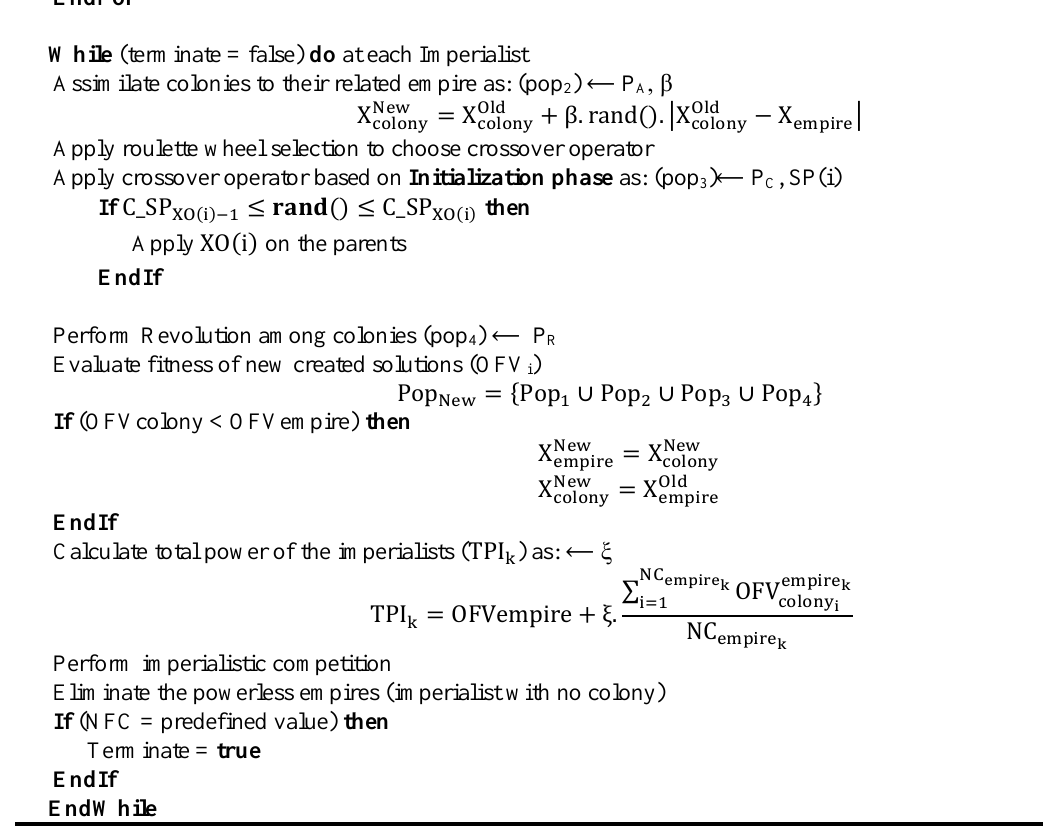
Figure 5. Pseudo code of SAICA’s main